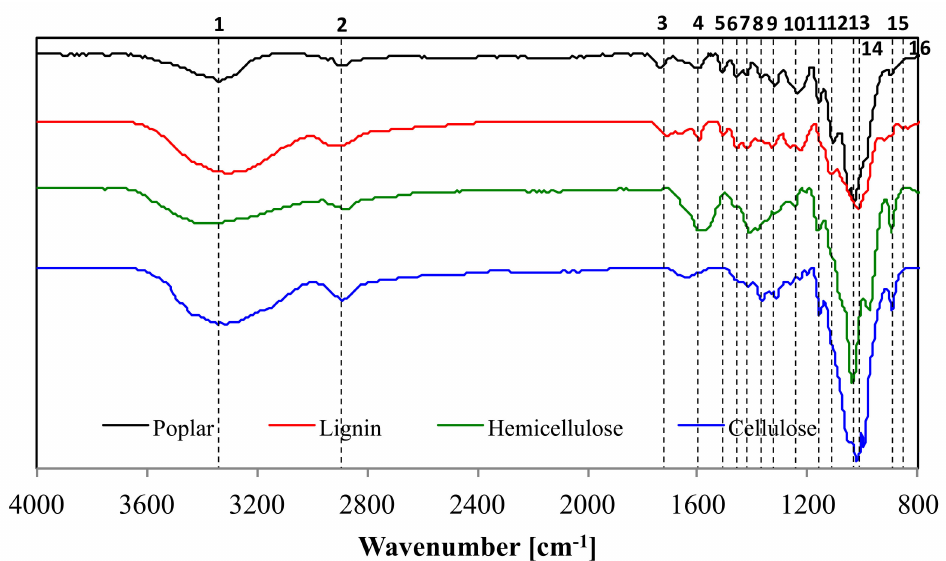
Figure 1. FTIR spectra of poplar and its major components: cellulose, hemicellulose, and lignin. (Note: The assignments of the numbered bands in the figure are described in Table